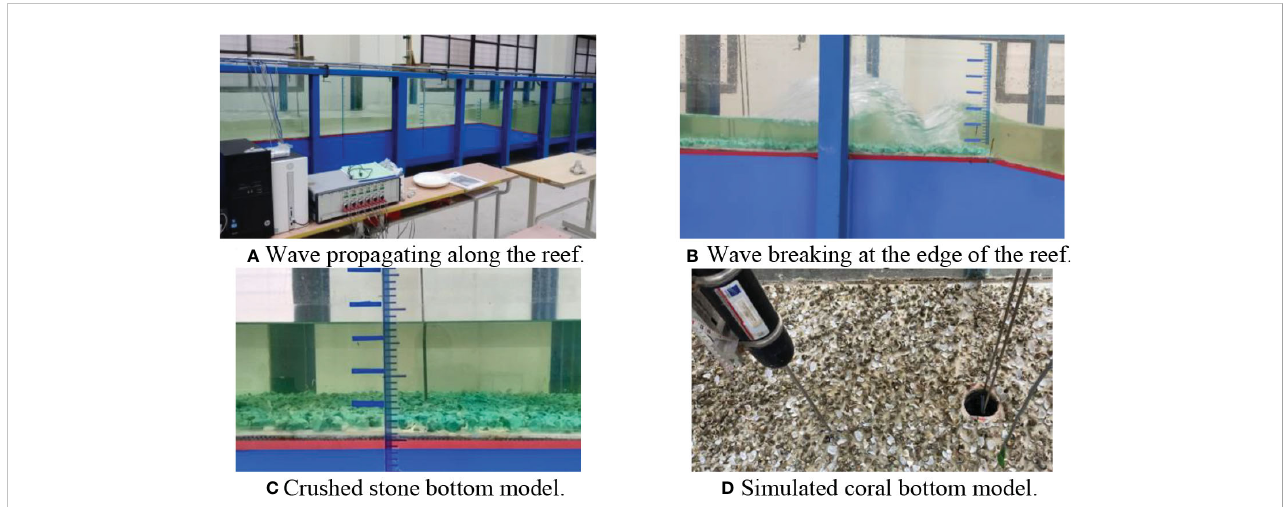
FIGURE 3 Snapshots of the physical models. (A) Wave propagating along the reef. (B) Wave breaking at the edge of the reef. (C) Crushed stone bottom model. (D) Simulated coral bottom